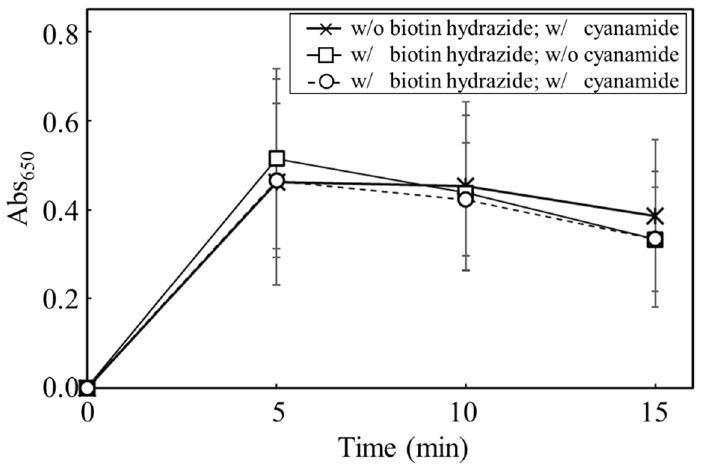
Figure 6. Time-course profiling of Abs 650 for the carbon materials prepared with each treatment.